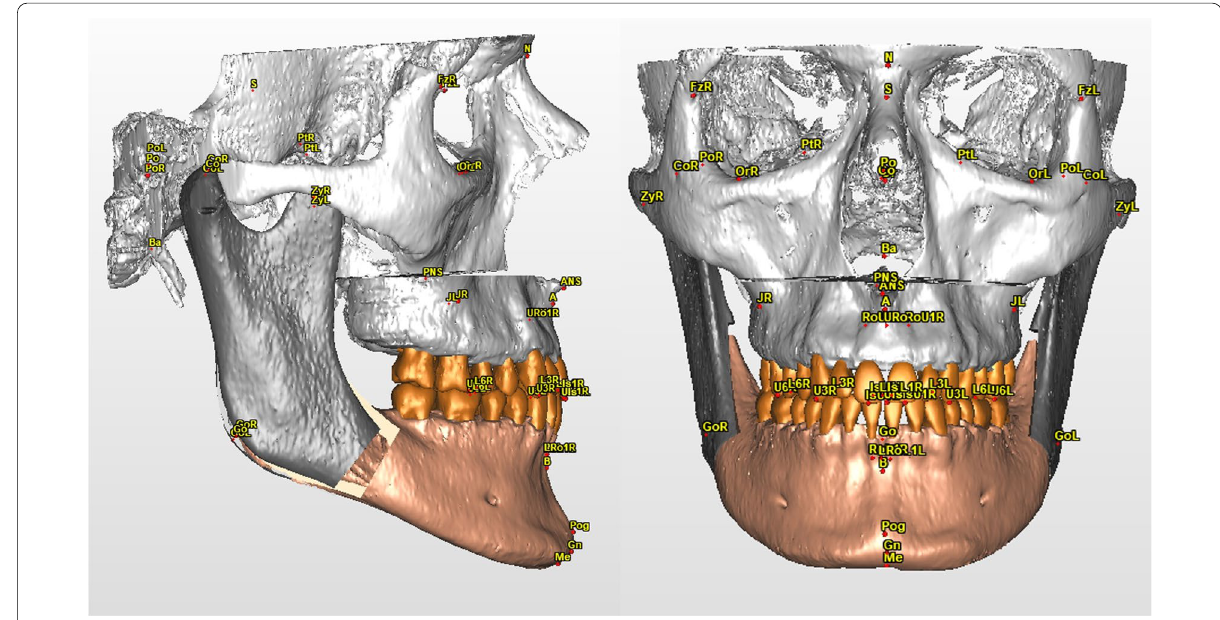
Fig. 1 Skeletal and dental cephalometric landmarks in a VOSP representation